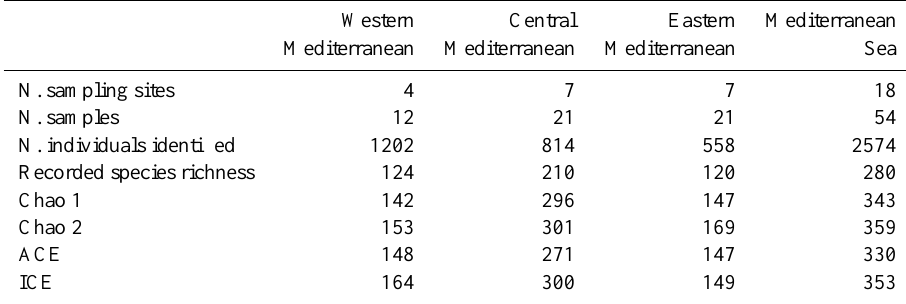
Table 5. Number of sites, samples, individuals and species identified in the western, central and eastern Mediterranean and overall in the Mediterranean Sea. Chao1 and ACE are abundance-based estimators; Chao2 and ICE are incident-based